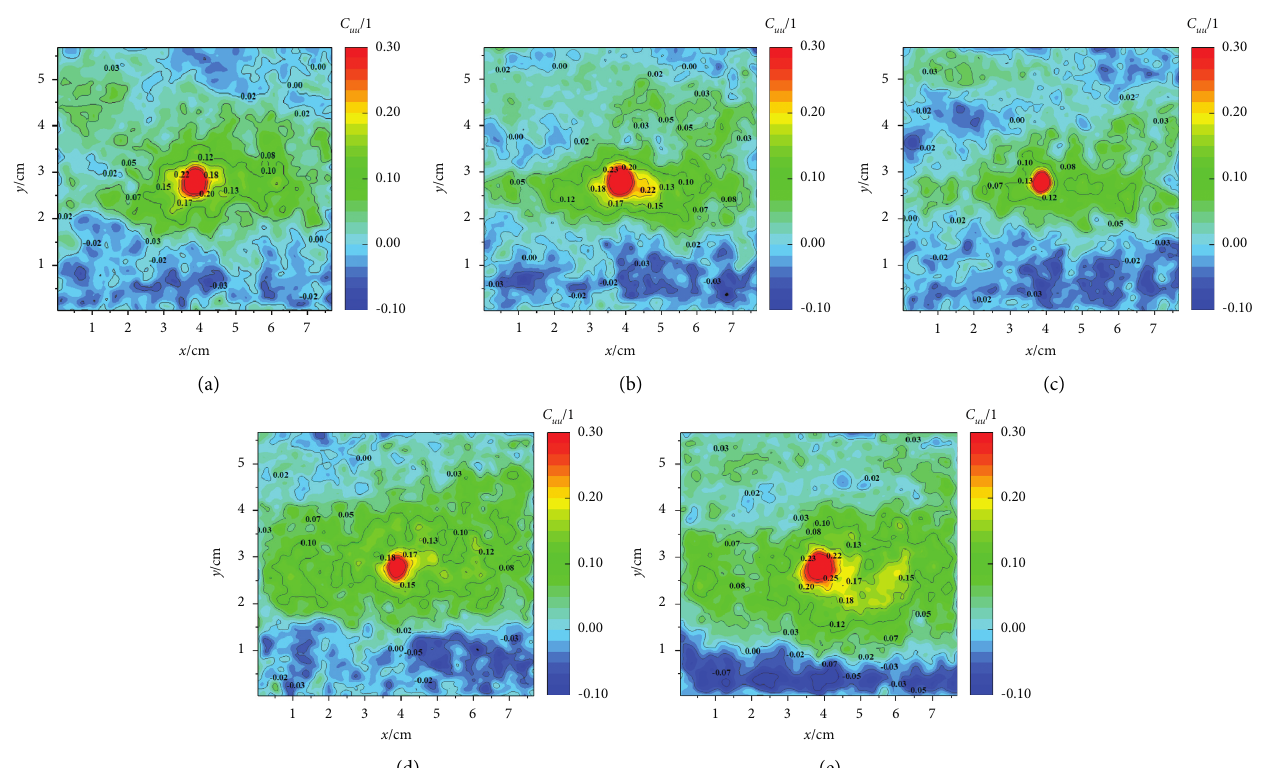
Figure 7: The distribution of C